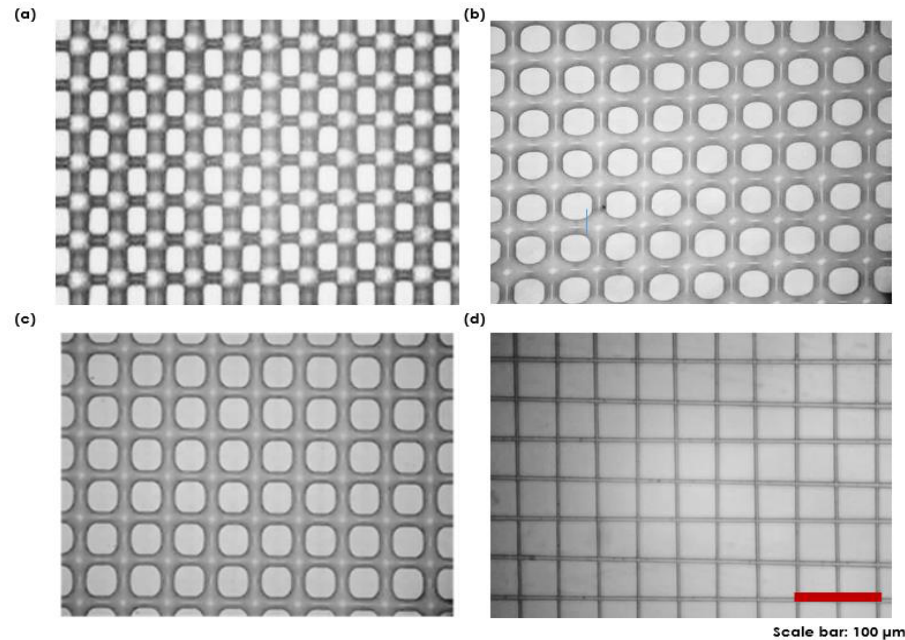
Figure 5. Microscopic images of PDMS mesh patterns fabricated by ( a ) direct ink writing (0 V) and ( b ) EHD jet printing at ( b ) 1.5 kV, ( c ) 2.3 kV, and ( d ) 2.8 kV.